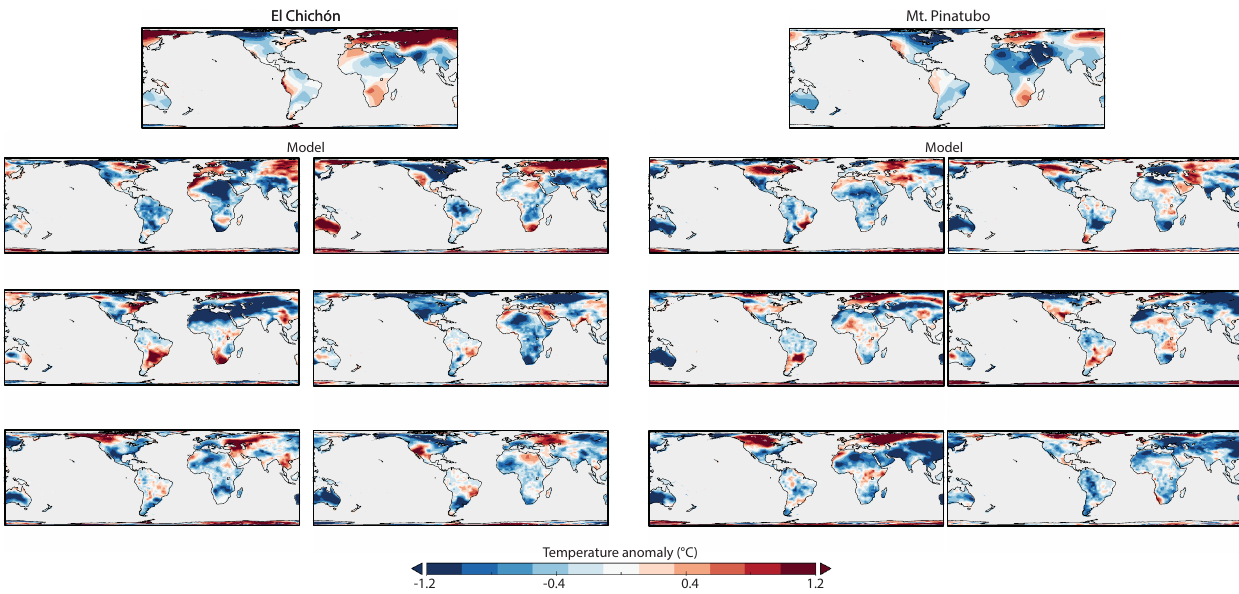
Figure 5. Annual-mean temperature change ( ◦ C, ocean masked) for each L20 eruption (labeled on plot) in GISTEMP (top row) and each ModelE2-R ensemble member, as discussed in the text. All plots use ENSO-removal procedure described in the text.